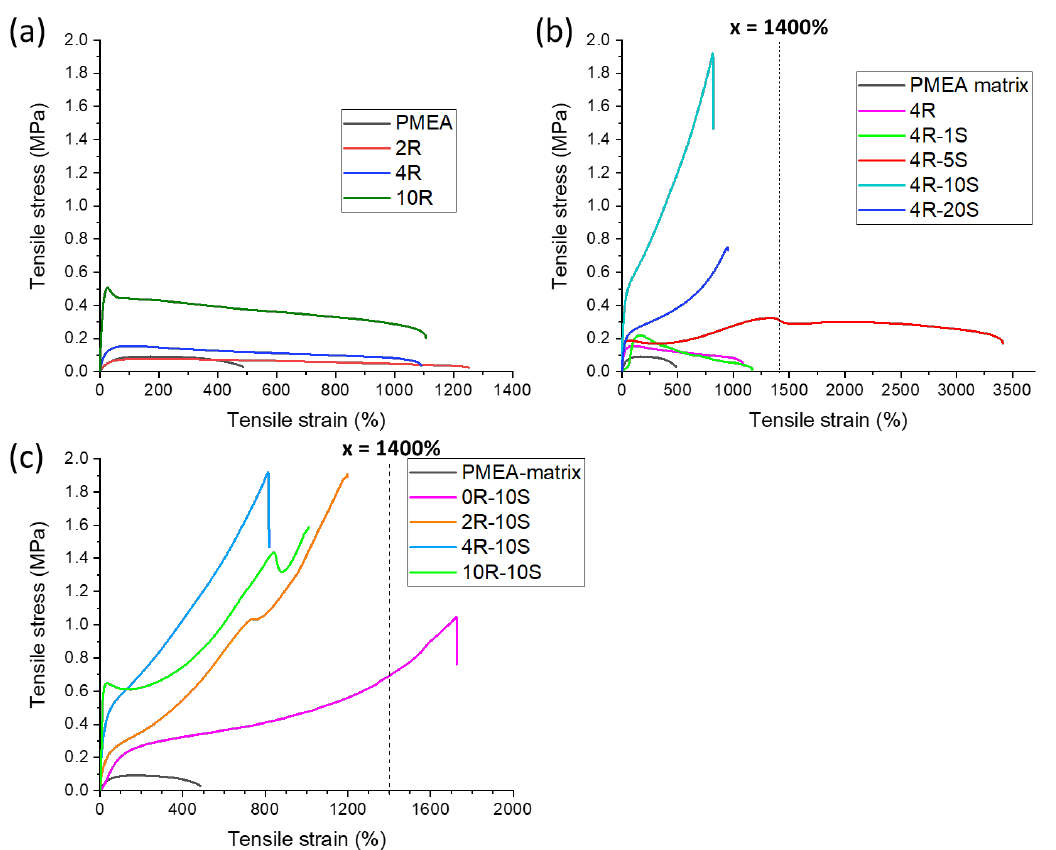
Figure 8. Tensile curves of ( a ) reference materials PMEA (neat polyMEA matrix), 2R (polyMEA/2% RDS clay), 4R and 10R; ( b ) effect of SMA co-monomer content (0–20 mol%) in the polyMEA nanocomposites with 4 wt% clay: tensile curves of PMEA (neat polyMEA matrix), 4R (polyMEA/4% RDS clay), 4R-1S, 4R-5S (poly[MEA-co-5mol%SMA]/4% RDS clay), 4R-10S and 4R-20S; ( c ) effect of a constant SMA content (10 mol%) in systems crosslinked by different amounts of RDS clay: tensile curves of: 2R-10S, 4R-10S, and 10R-10S, compared with neat